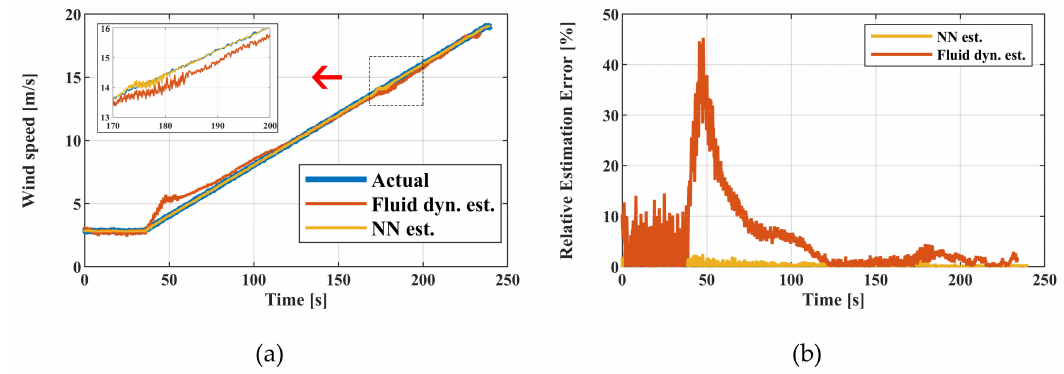
Figure 12. Wind speed: ( a ) actual and estimated wind speed pattern; ( b ) relative (percentage) estimation